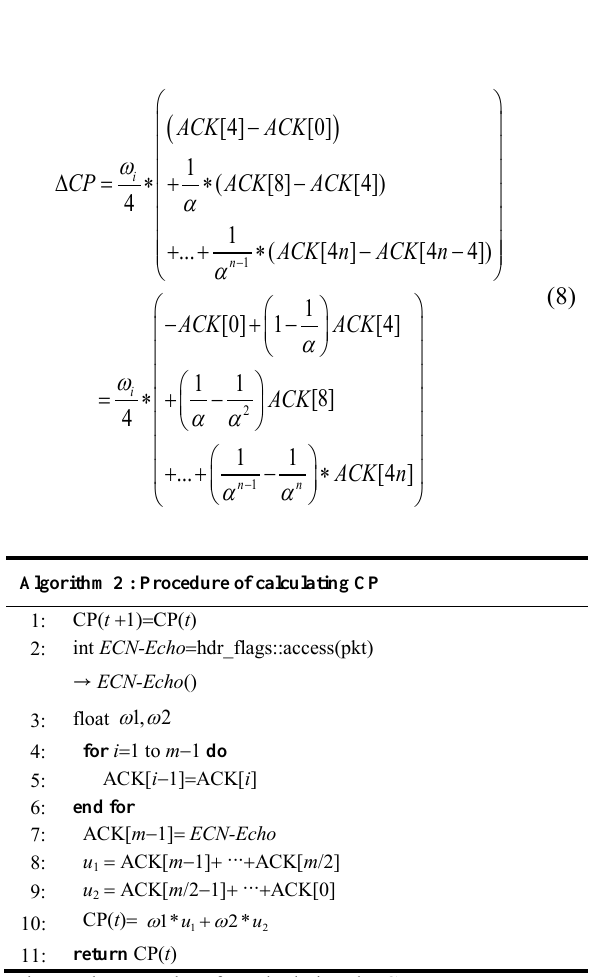
Fig. 7. The procedure for calculating the